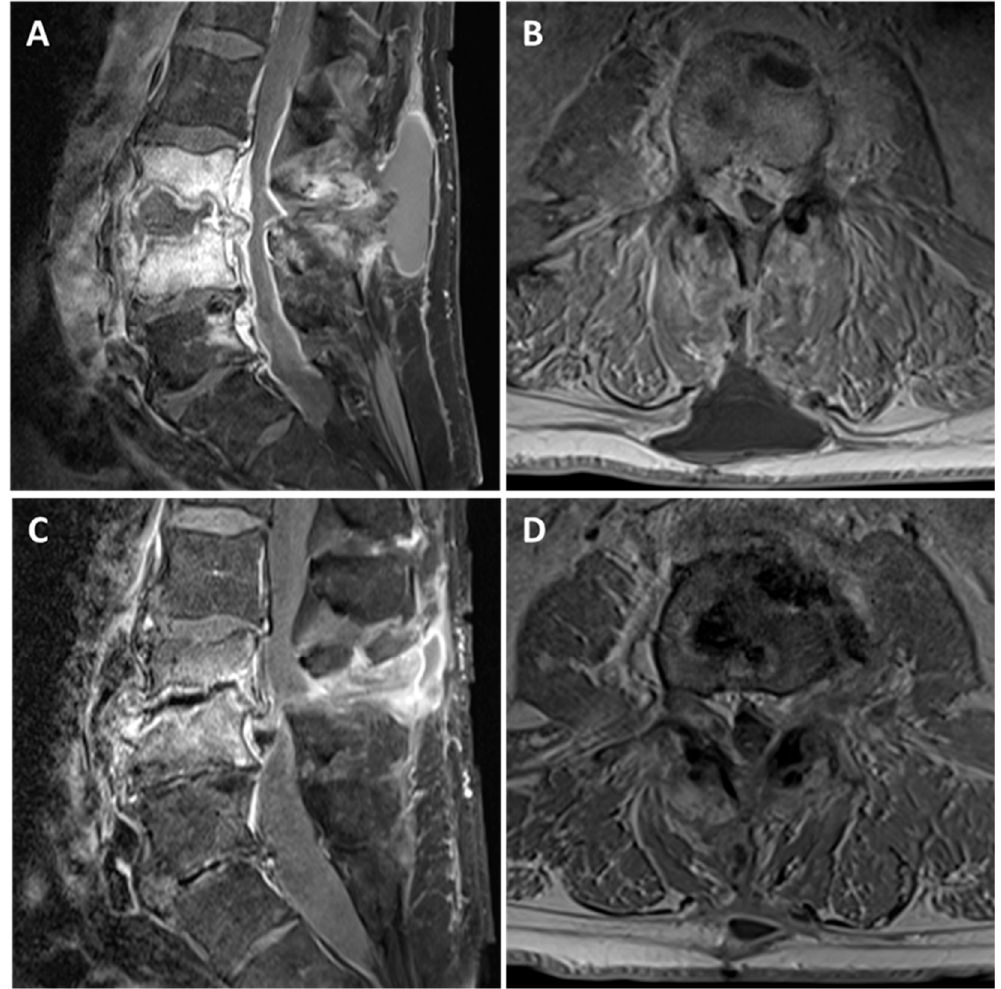
Figure 1. The appearances of L3/4 spondylodiscitis before and after antimicrobial therapy. Representative T1 fat saturated post-gadolinium sagittal ( A , C ) and axial ( B , D ) Magnetic Resonance images. ( A , B ) At presentation, there is a rim enhancing collection within L3/4 disc space with destruction of the adjacent vertebral body end plates. In addition, there is an associated enhancing epidural phlegmon causing severe cauda equina compression and a homogenous subcutaneous fluid collection. ( C , D ) Six months later, following antimicrobial therapy, there is significant improvement in the inflammatory appearances at L3/4 disc space and the fluid collections. However, there is a significant loss of disc height at L3/4 leading to moderate-severe canal stenosis.